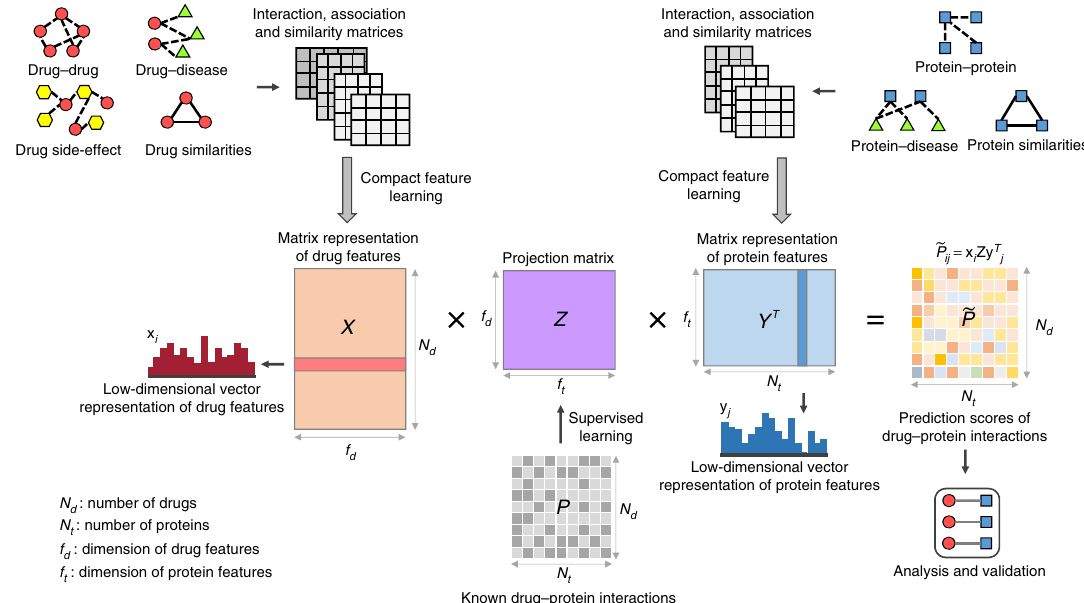
Fig. 1 The fl owchart of the DTINet pipeline. DTINet fi rst integrates a variety of drug-related information sources to construct a heterogeneous network and applies a compact feature learning algorithm to obtain a low-dimensional vector representation of the features describing the topological properties for each node. With the learned compact features X and Y for drugs and proteins (i.e., each row in X and Y represents the feature vector of a drug and a protein, respectively), DTINet then fi nds the best projection from drug space onto protein space, such that the projected feature vectors of drugs are geometrically close to the feature vectors of their known interacting proteins. The projection matrix Z is learned to minimize the difference between the known interaction matrix P and XZY T (see Supplementary Note 1 for more details). After that, DTINet infers new interactions for a drug by sorting its target candidates based on their geometric proximity to the projected feature vector of this drug in the projected space. The predicted new drug – target interactions can be further analyzed and experimentally